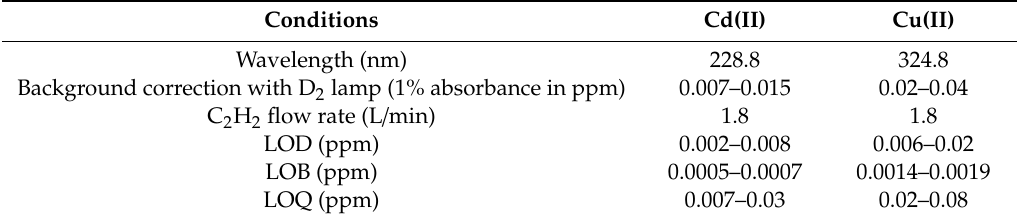
Table 1. Standard conditions for Cd(II) and Cu(II)